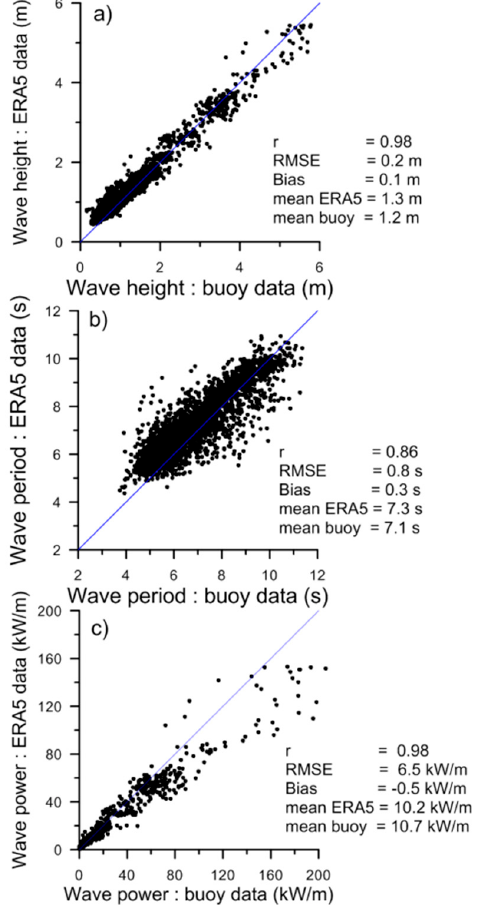
Figure 2. Scatter plots of ( a ) significant wave height, ( b ) mean wave period, and ( c ) wave power from ERA5 and